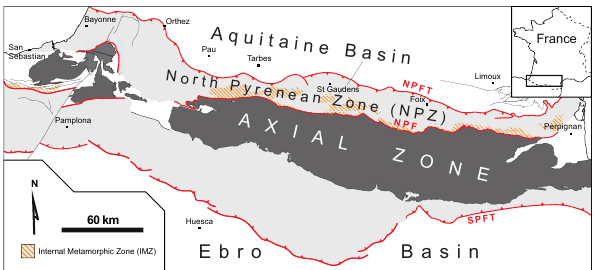
Figure 1. Simplified structural map of the northern flank of the Pyrenean belt. The area between the North Pyrenean Fault (NPF) and the North Pyrenean Frontal Thrust (NPFT) is known as the North Pyrenean Zone